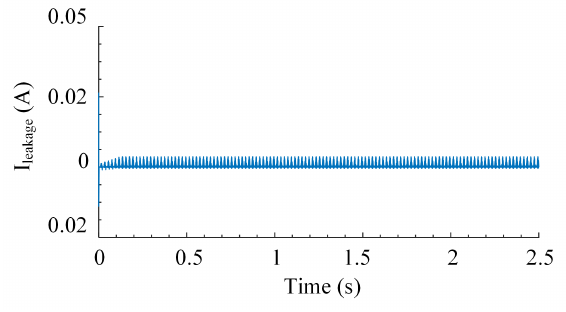
Figure 15. Leakage current at P max = 70